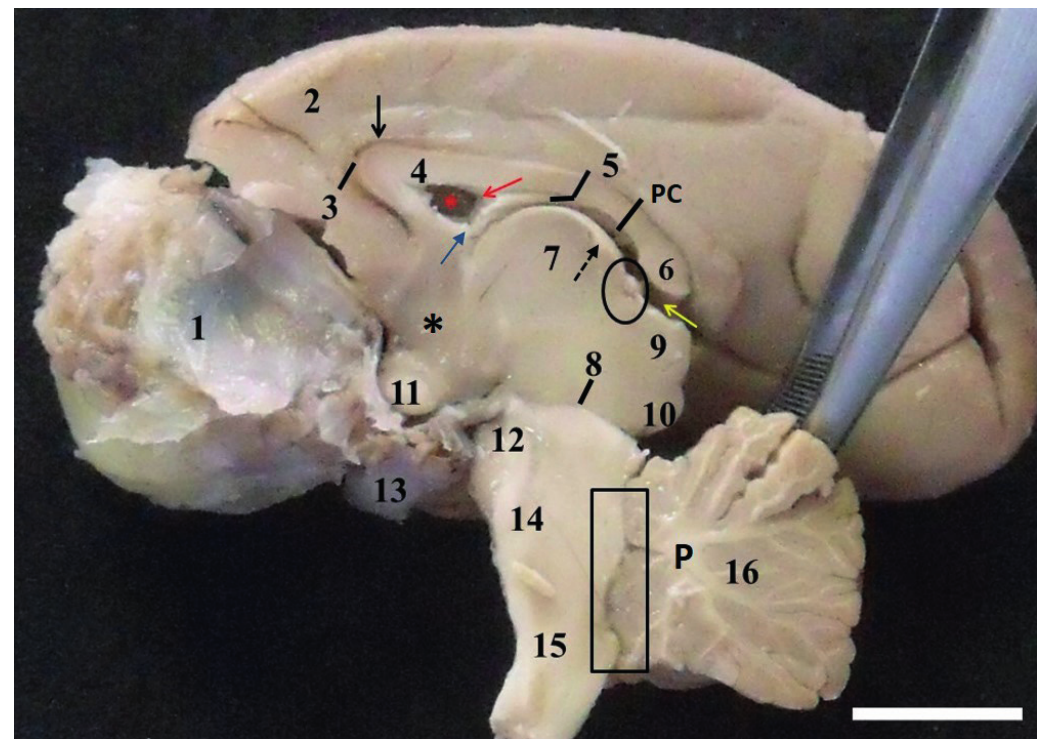
Figure 4 - Photomacrograph of the brain of Saimiri collinsi. Medial view of the brain showing the following structures: right ocular globe (1), right cerebral hemisphere (2), knee of the corpus callosum (3), corpus callosum sulcus (arrow), corpus callosum (4), right lateral ventricle (*), part septum pellucidum (red arrow), fornix (5), splenium of the corpus callosum (6), pineal (circle), III ventricle (yellow arrow), interthalamic commissure (thalamus) (7), cerebral aqueduct (8), rostral colliculus (9), caudal colliculus (10), making quadruplet bodies, optic chiasm (11), cerebral peduncle (12), hypophysis (13), pons (14), bulb (15), IV ventricle (rectangle) , cerebellum (16) with the middle cerebellar peduncle (P), hypothalamus (*), rostral commissure (blue arrow), caudal commissure (dashed arrow) and choroid plexus (CP). Scale bar: 1